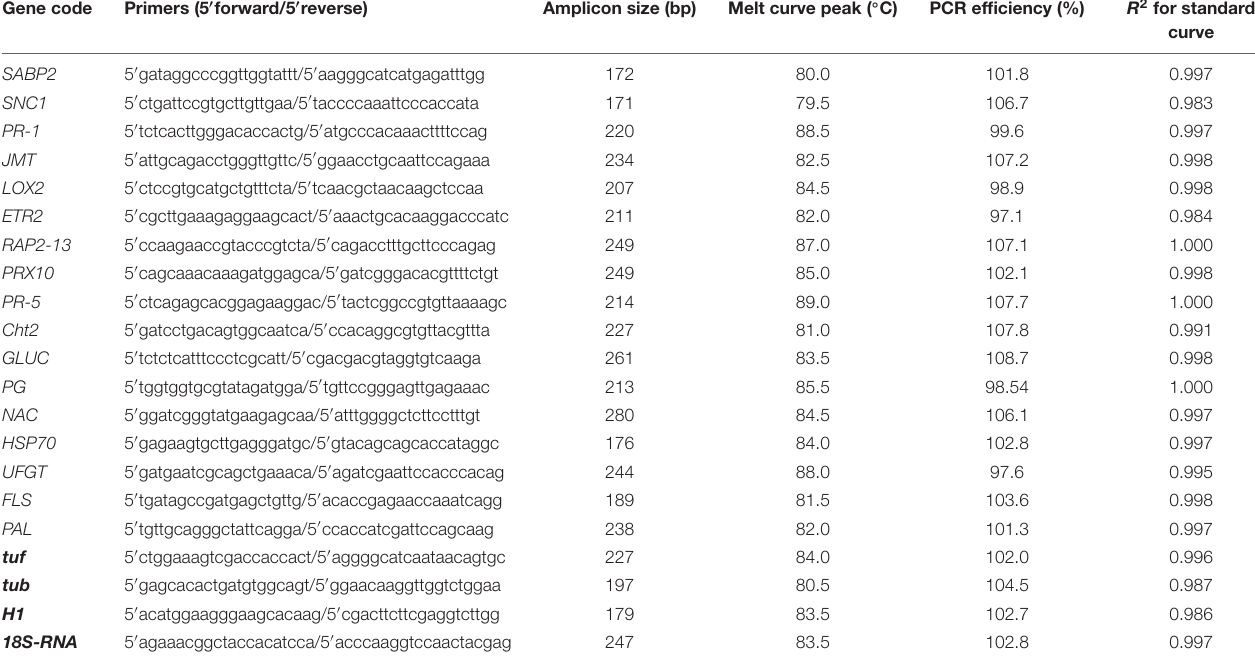
TABLE 3 | Primer pairs were selected for gene expression analysis and related PCR amplification efficiencies data. Gene code Primers (5 (cid:48) forward/5 (cid:48) reverse) Amplicon size (bp) Melt curve peak ( ◦ C) PCR efficiency (%) R 2 for standard